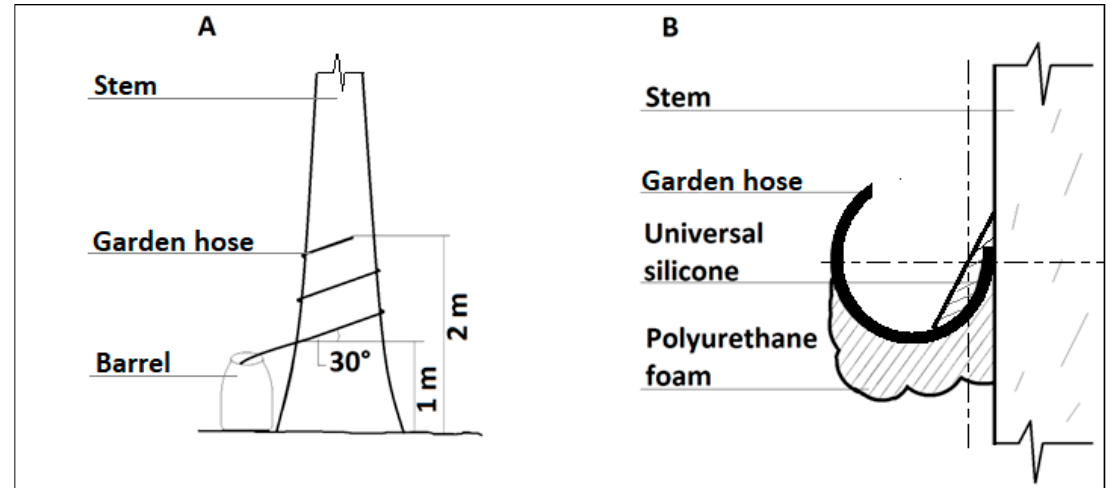
Figure 1. The measuring of the stemflow. ( A ) Stemflow and ( B ) anchoring of the hose to the trunk.